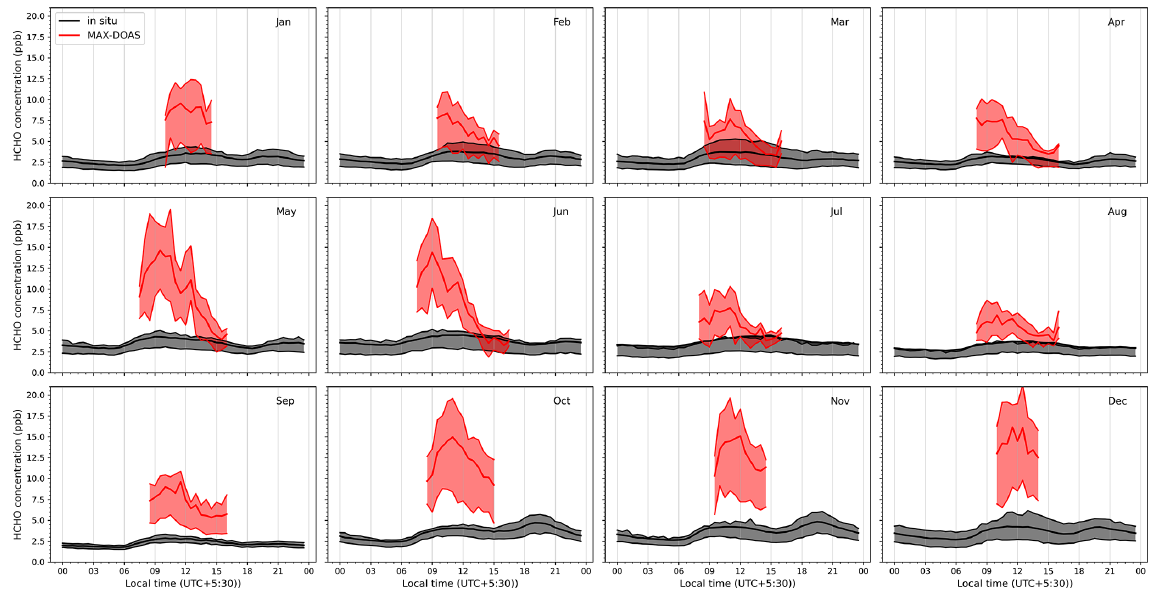
Figure F8. Mean diurnal profiles of surface HCHO mixing ratios measured by the PTR-MS (black) and retrieved from the MAX-DOAS measurements (red) for different months of the year. The dark line represents the mean value, while the shaded region above and below the dark lines represent the 75th and 25th percentiles,